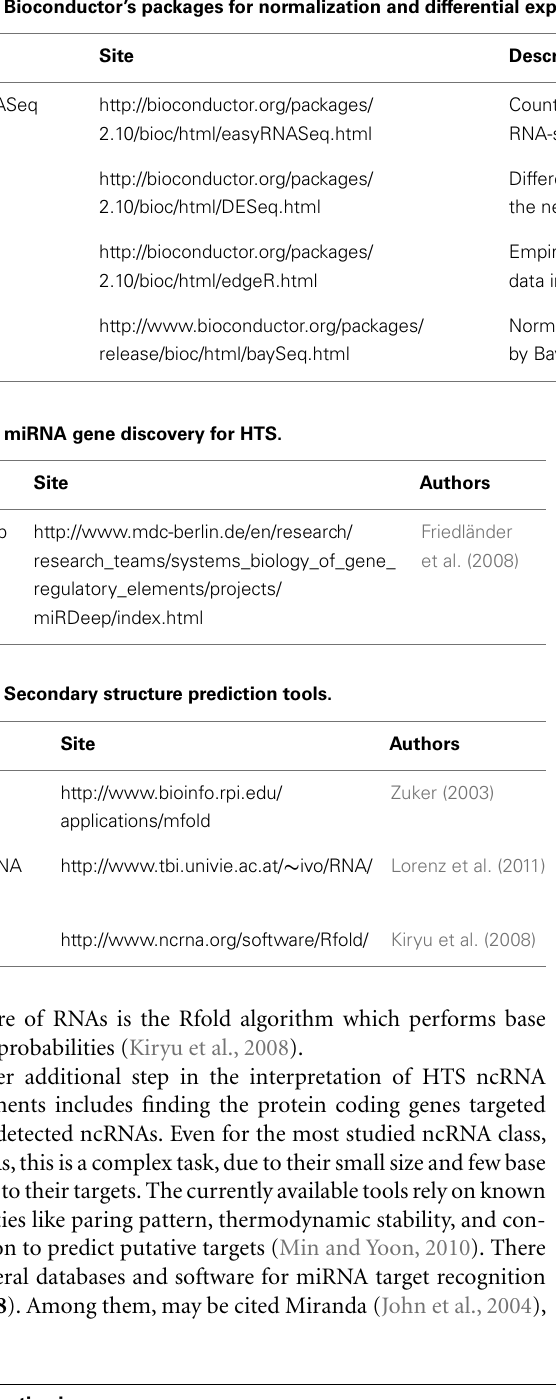
Table 5 | Bioconductor’s packages for normalization and differential expression of HTS data.